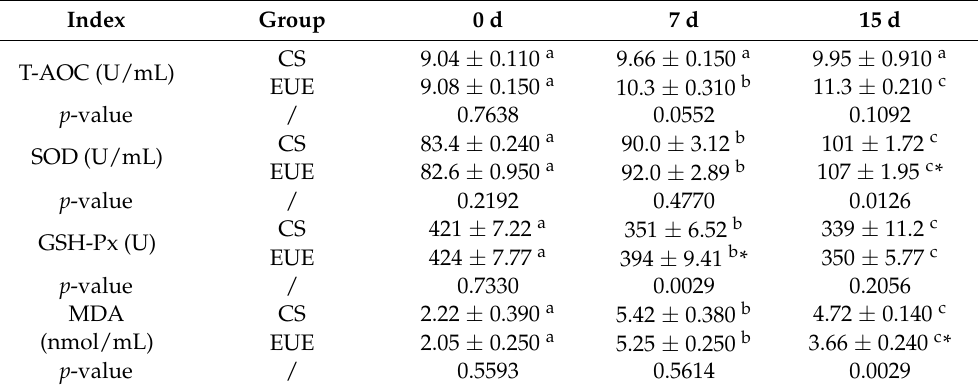
Table 6. The oxidative and antioxidative indicators in chick serum under cold